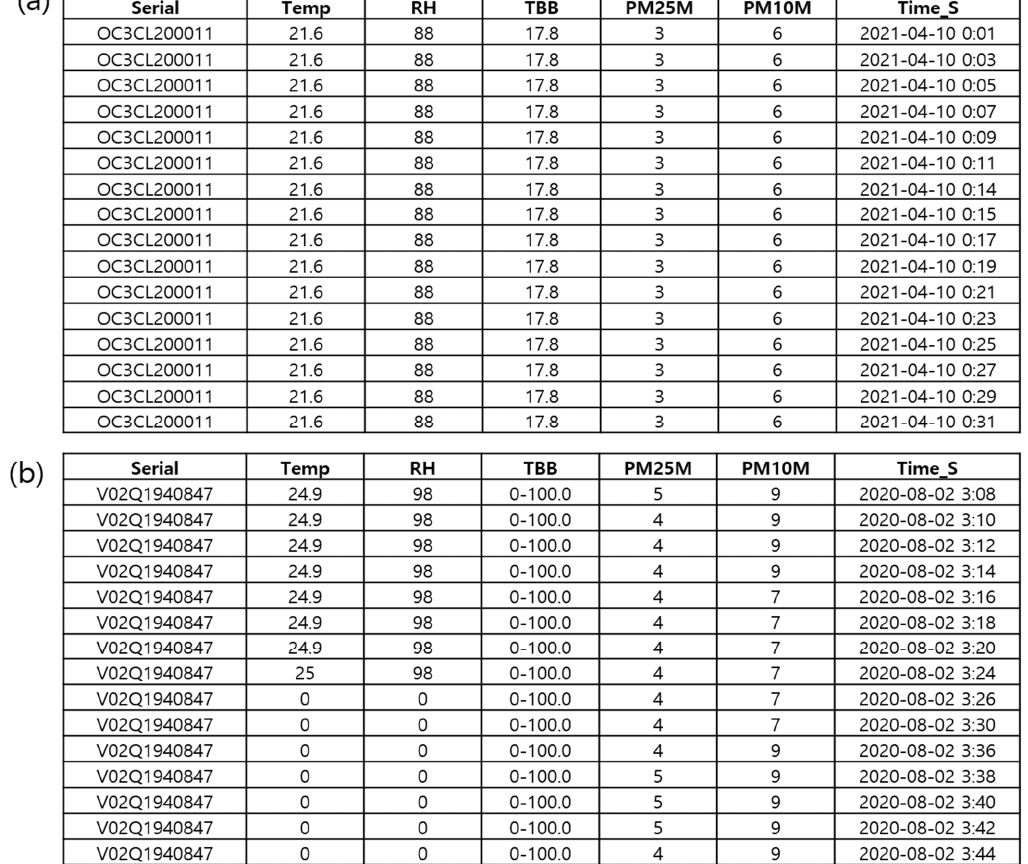
Figure 11. Example of erroneous data found using the ( a ) persistence and ( b ) step check.